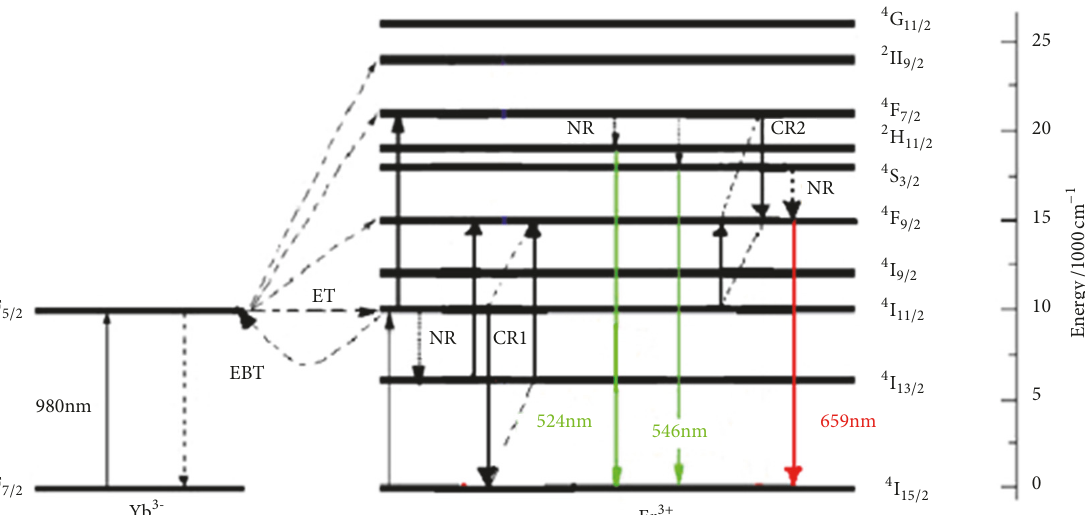
Figure 9: Schematic diagram of energy levels of Er 3+ , Yb 3+ ions and possible transitions under 980nm excitation. EBT: energy back transfer; ET: energy transfer; NR: nonradiative